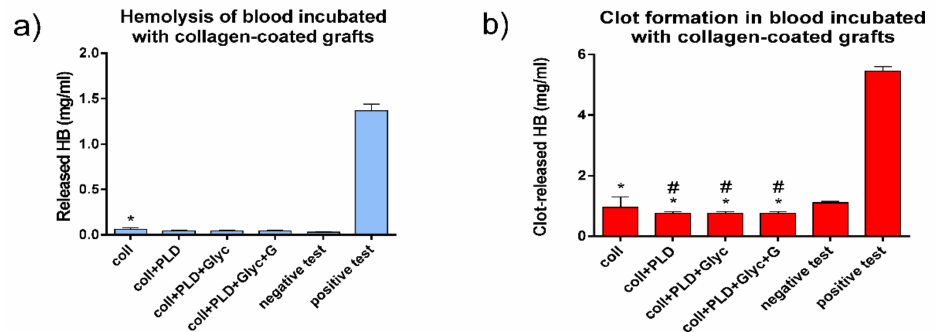
Figure 3. Hemolysis ( a ) and clot formation ( b ) in blood incubated with Coll, Coll+PLD and Coll+PLD+Glyc grafts. (*) symbol indicates statistically significant results between negative test and all samples; (#) symbol indicates statistically significant results between Coll and the rest of the samples, according to one-way ANOVA with post-hoc Tukey’s test ( p <